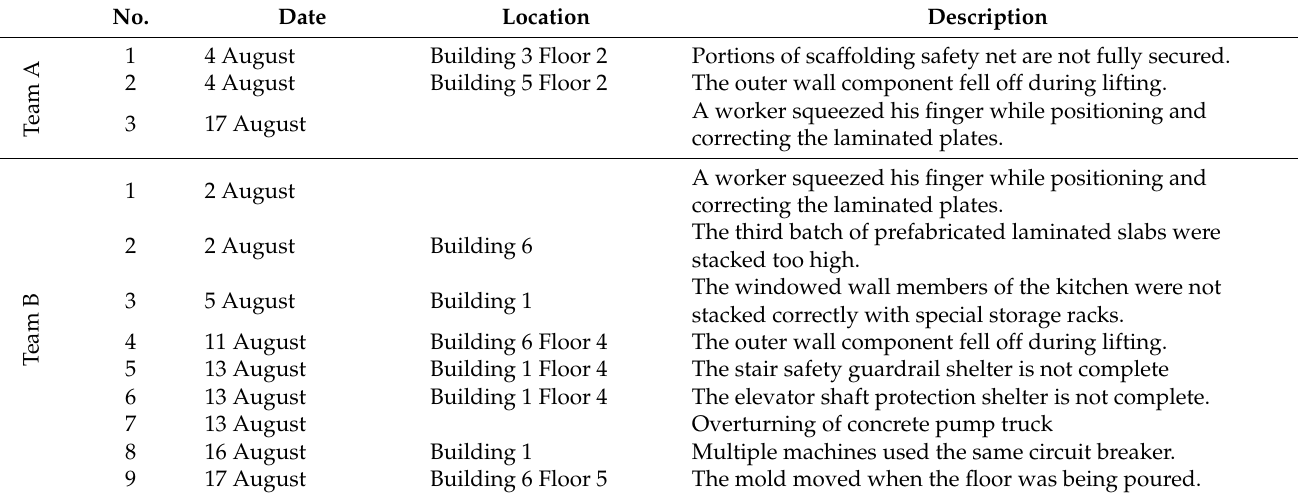
Table 14. Comparison of workers’ unsafe behaviors between the two hoisting